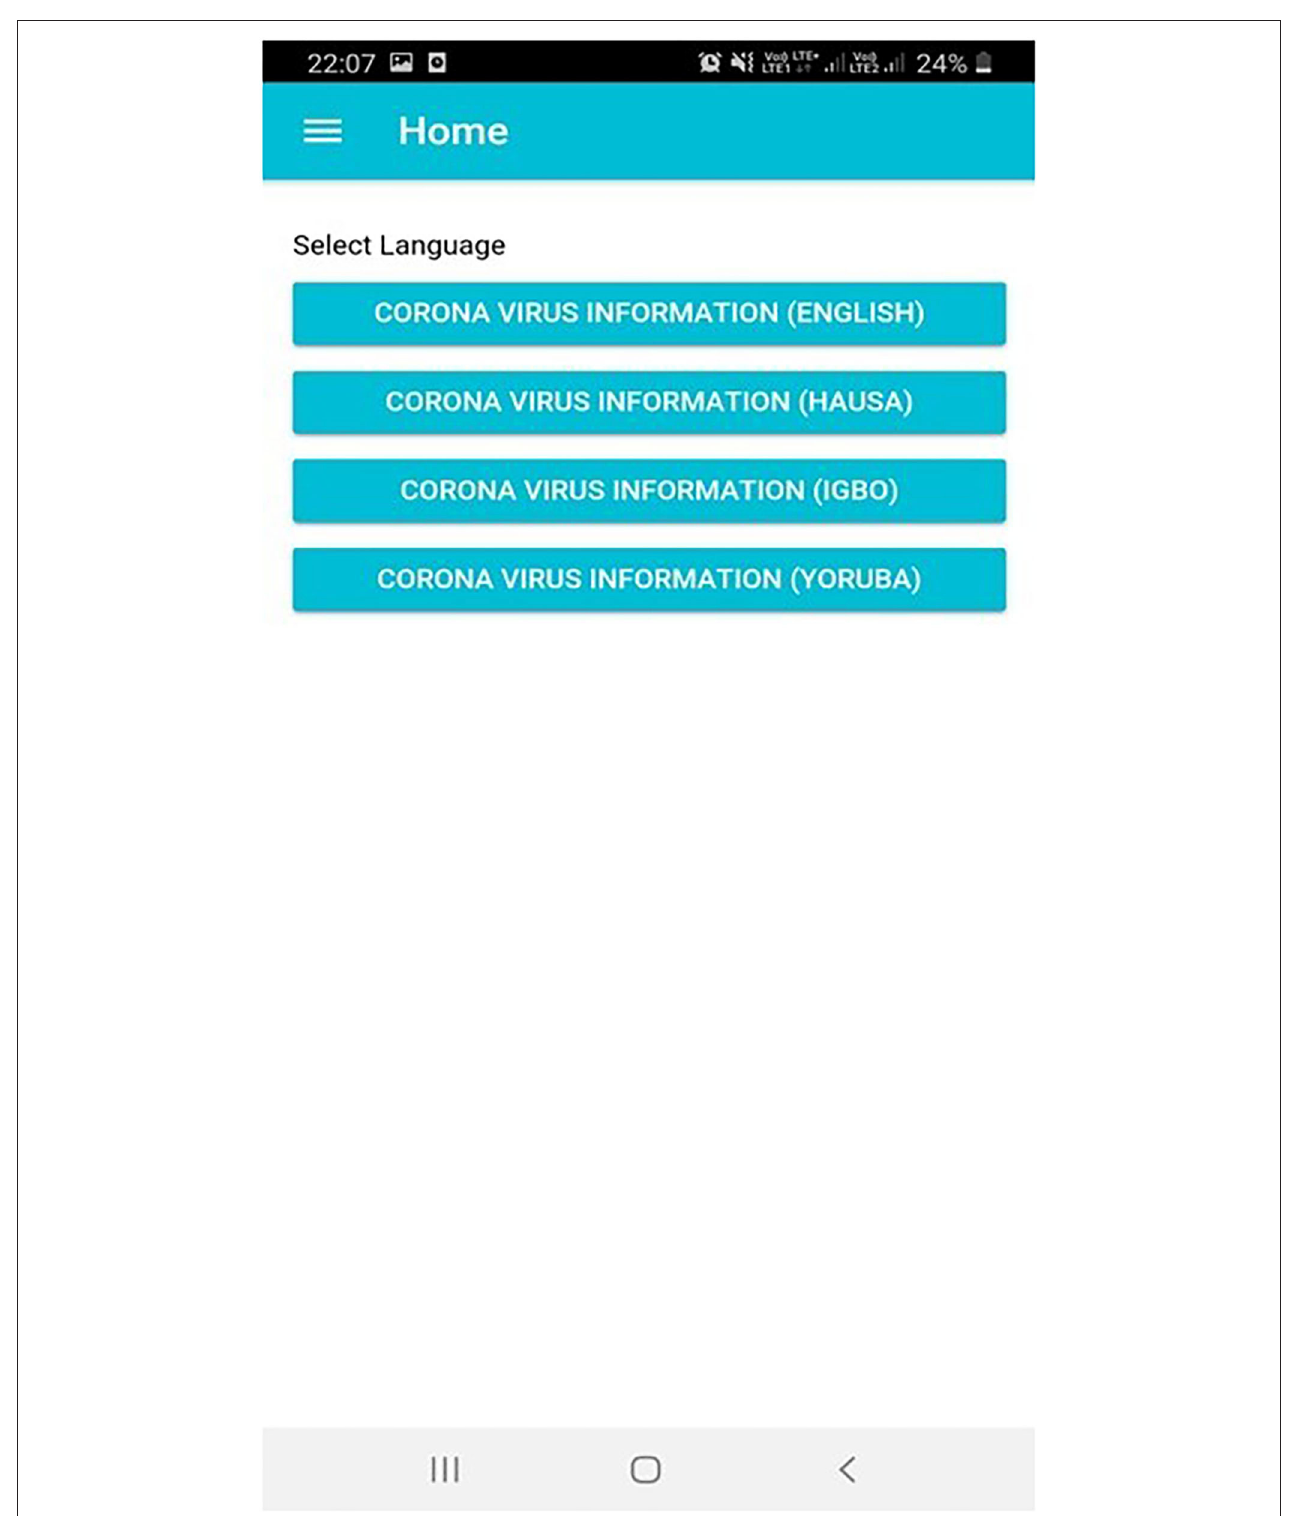
FIGURE 4 | Screenshot of the InStrat COVID-19 Mobile App showing the various language options available.